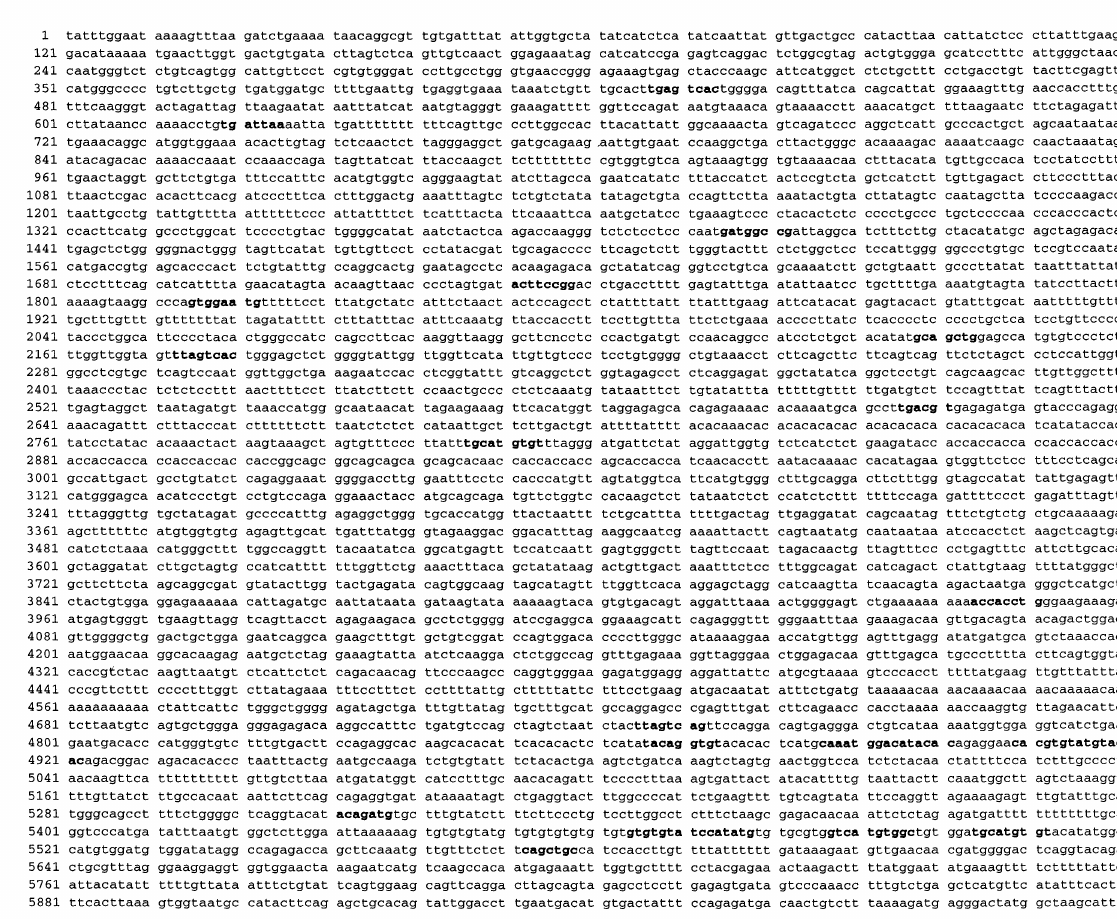
FIGURE 2 Sequence of the murine RAG locus intergenic region (accession number U96151). Boldface sequences are the potential transcription-factor binding sites listed in Table